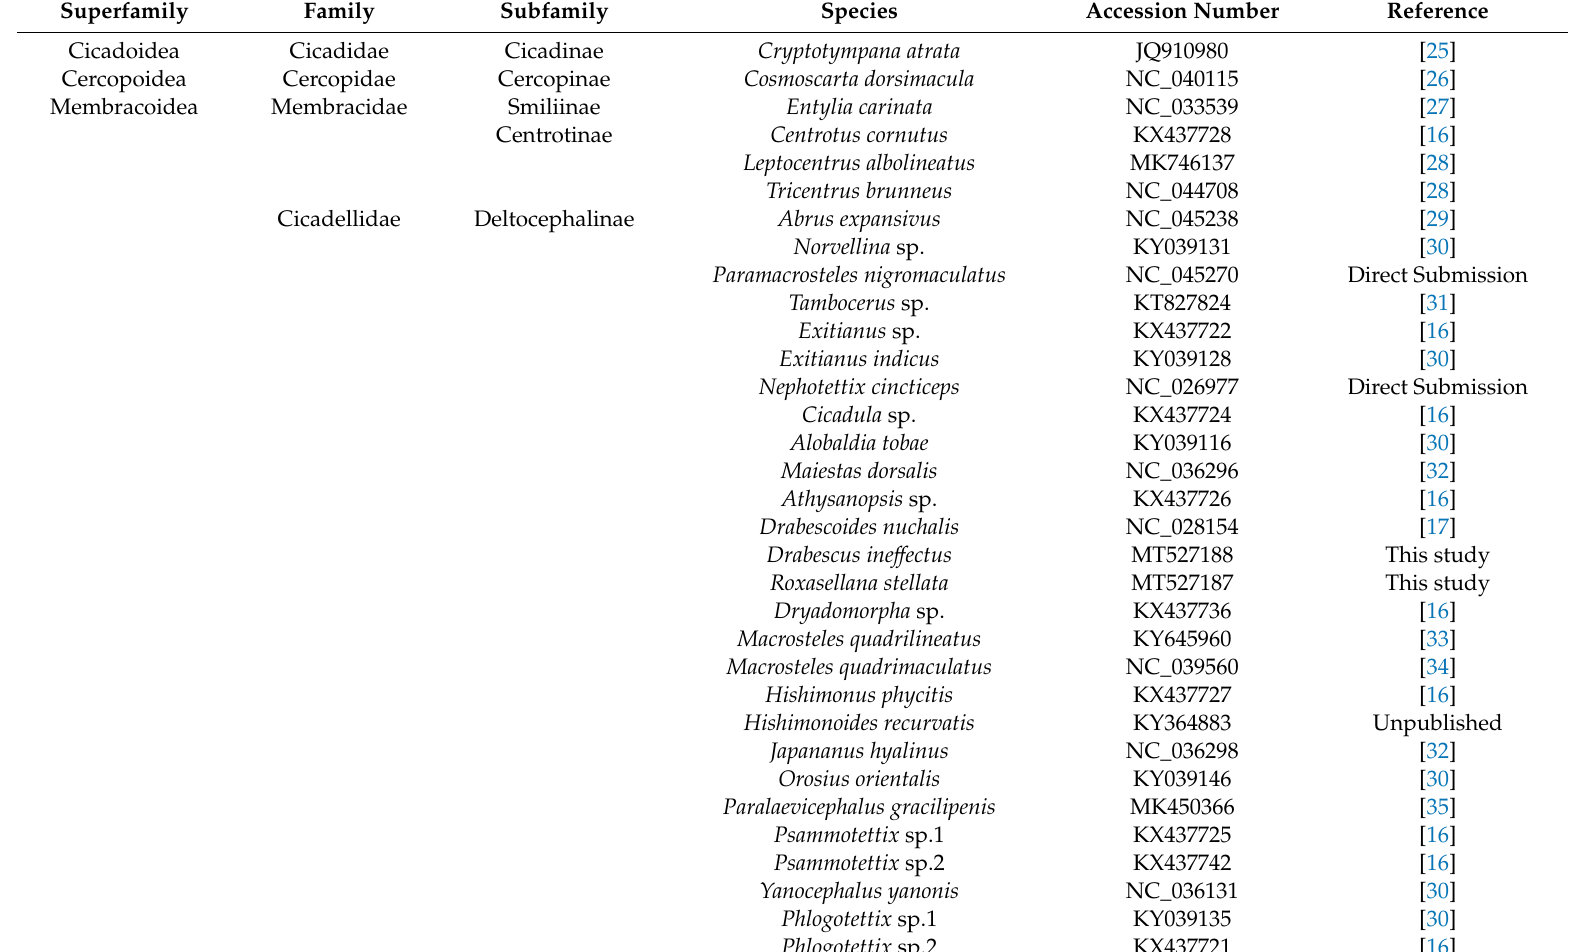
Table 1. Mitochondrial genomes used for phylogenetic analysis in present